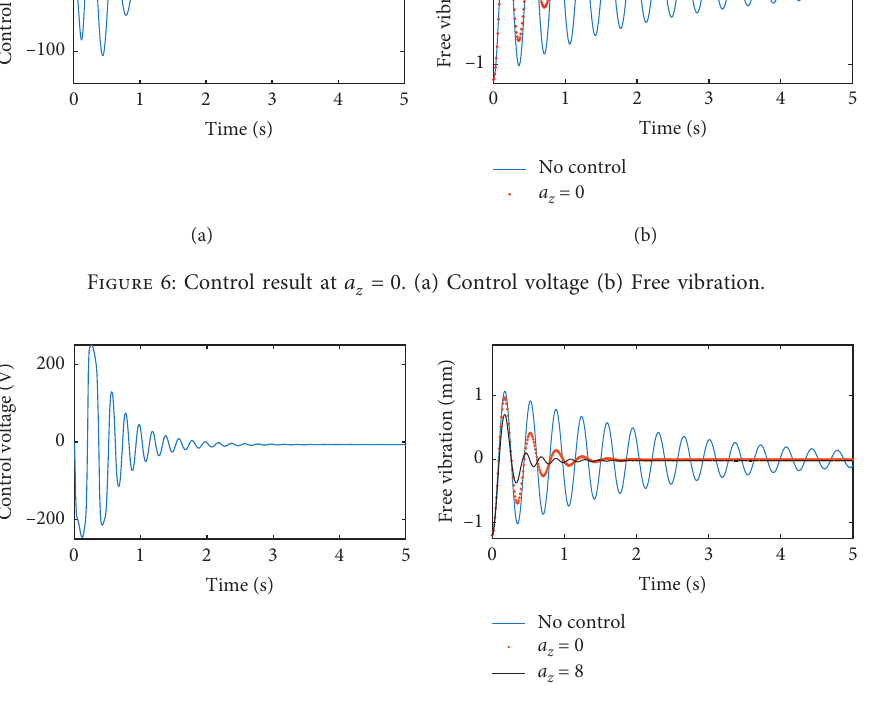
� 8. (a) Control voltage (b) Free vibration. z